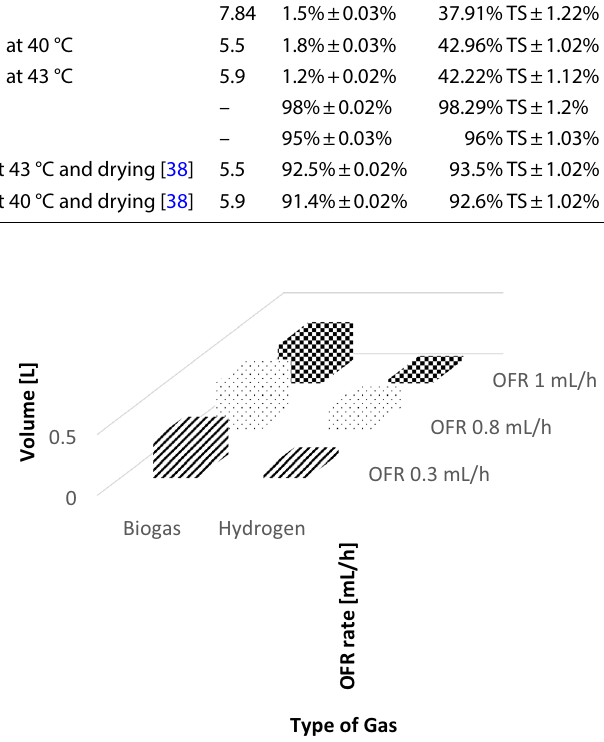
Table 1 Characteristics of inoculums and substrate